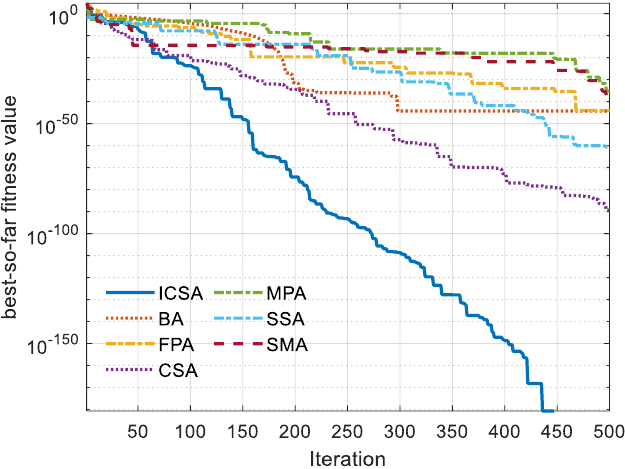
Figure 16. Convergence curve for F16.